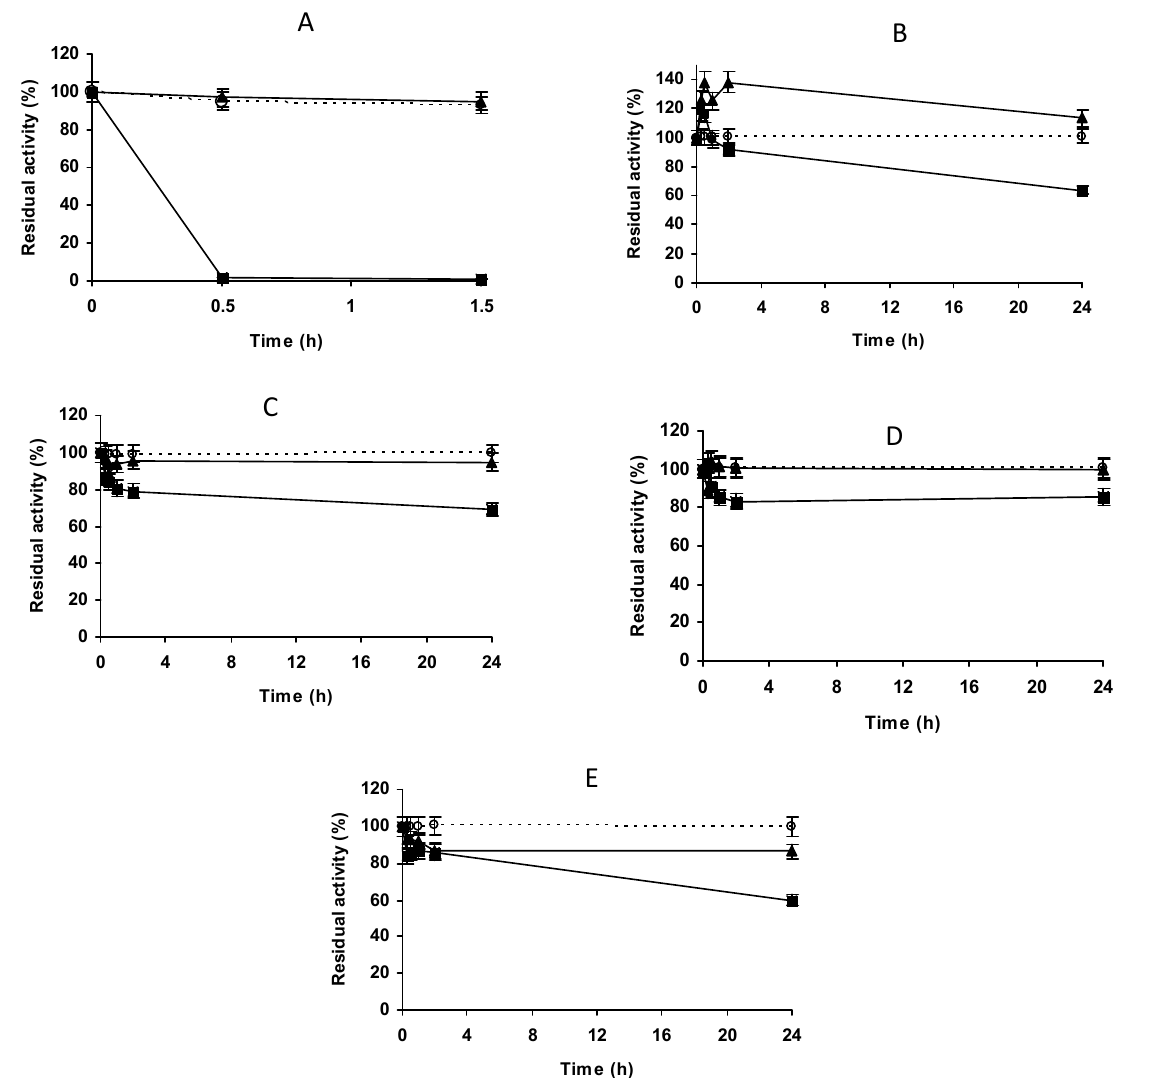
Figure 1. Immobilization courses of PGA (2.5 mg/g) on vinyl sulfone agarose at different pH values. ( A ) Immobilization on glyoxyl agarose support at pH 10; ( B ): immobilization in VS-agarose at pH 7.0; ( C ) immobilization in VS-agarose at pH 8.0; ( D ) immobilization in VS-agarose at pH 9.0; ( E ) immobilization in VS-agarose at pH 10.0. Empty circles with dashed line: reference suspension. Full triangles with solid line: suspension. Full squares with solid line: supernatant. Other specifications are described in Methods.